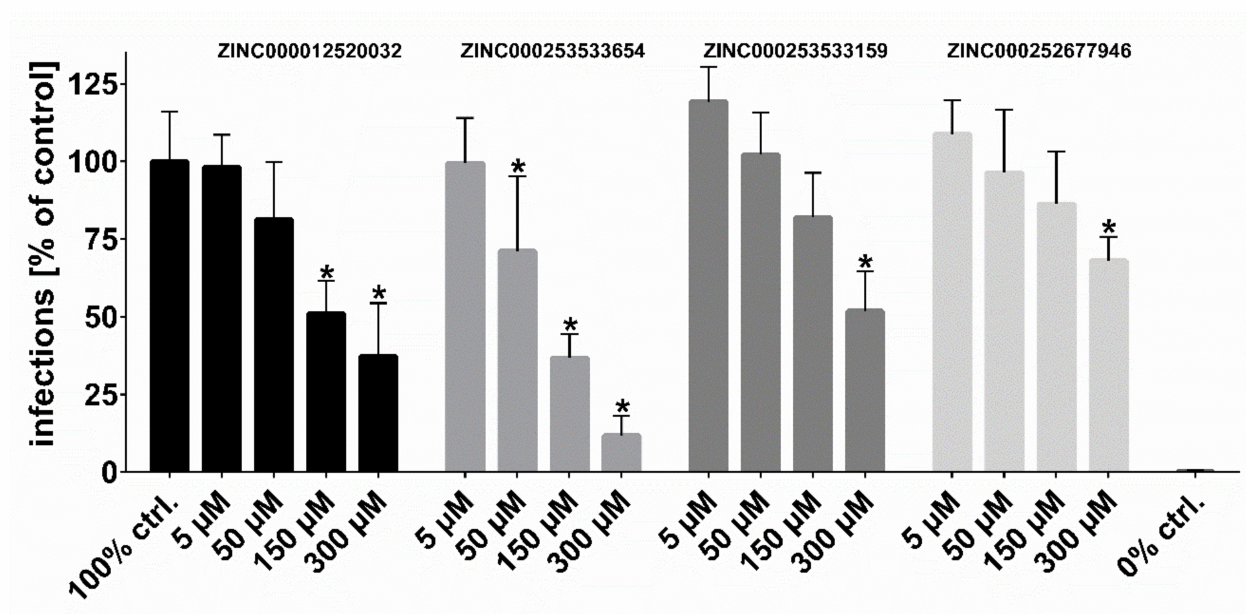
Figure 8. HDV infection studies. NTCP-HepG2 cells were pre-incubated for 5 min with the indicated concentrations of the respective inhibitors in DMEM at 37 ◦ C. Then, cells were additionally inoculated with 120 genome equivalents/cell of HDV particles at 37 ◦ C. After 6 h, cells were washed and further incubated with inhibitor- and virus-free medium, and medium was changed every 3–4 days. At day 9 post infection, cells were fixed and an immunostaining against the HDAg was performed, as a marker of HDV infection. The number of infected cells per well was determined by fluorescence microscopy. NTCP-HepG2 cells incubated without inhibitor were used as control (set to 100% infection rate). Infection experiments in the presence of 0.5 µ M myr-preS1 2–48 lipopeptide served as 0% control (representing 0% infection rate). Data represent means ± SD of three independent experiments, each with triplicate determinations (n = 9). * Significantly lower than 100% control with p < 0.01.